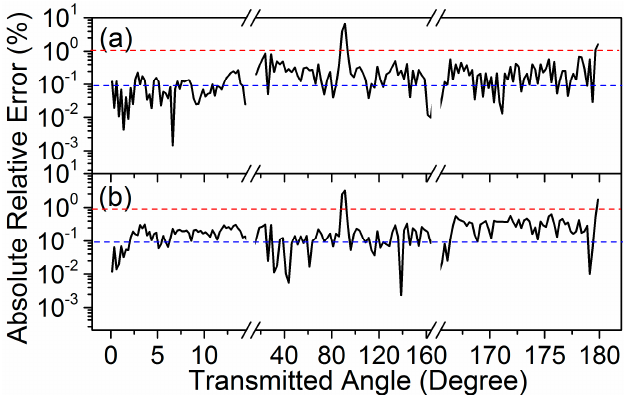
Figure 10. Absolute relative error of Markov chain approximations compared to Monte Carlo simulations with zenith angle discretization scheme 3. Phase function 3 was selected. Panel ( a ) OD = 2, Panel ( b ) OD = 5. The angular resolution was 0.25 ◦ for θ < 15 ◦ and θ > 165 ◦ ; 2.5 ◦ for θ > 15 ◦ and θ < 165 ◦ .